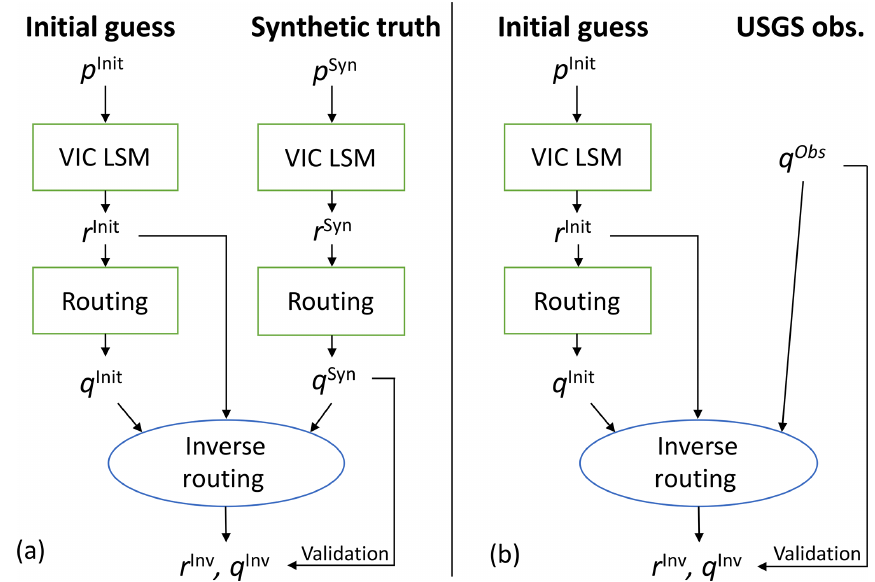
Figure 2. (a) Overall process flow diagram for the synthetic experiments with the ISR model, where p is the input precipitation for the VIC LSM distributed over the study domain and study period, r is the runoff fields distributed over the same space, and q is discharge at discrete points during the study period. The superscripts “Init” and “Syn” represent the initial guess and the synthetic truth, respectively, while the “Inv” superscript indicates the products resulting from the model. (b) Overall process flow diagram for the ISR model, substituting actual USGS discharge observations for the synthetic truth of the previous experiments.